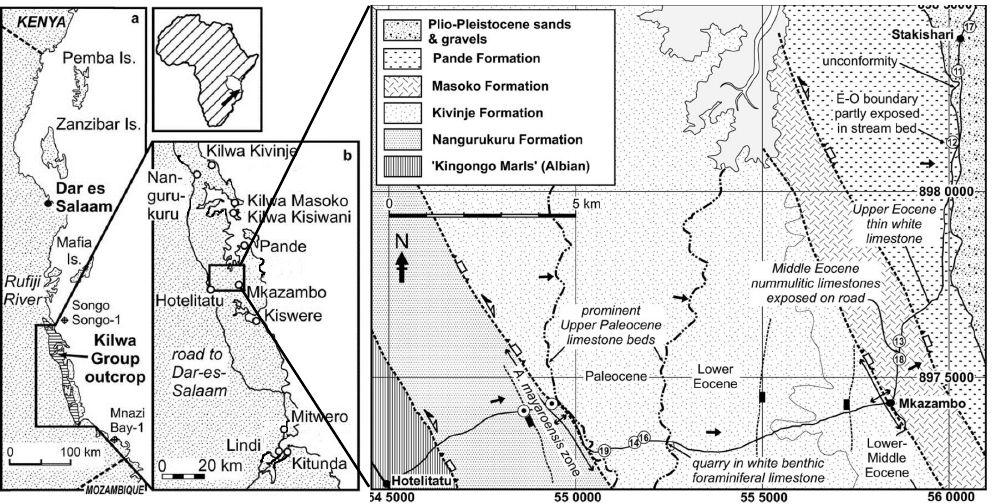
Figure 1. Location map. (a) Coastal Tanzania; (b) detail of Kilwa Group outcrop; (c) geological map showing principal faults and sites of several Tanzania Drilling Project drill cores (circled numbers). The proposed TOPIC drill site is at TDP site 12 as highlighted by the circle in the northeastern corner of the geological map. Note: the Pande through Nangurukuru formations comprise the Kilwa Group. Modified from Nicholas et al. (2006).